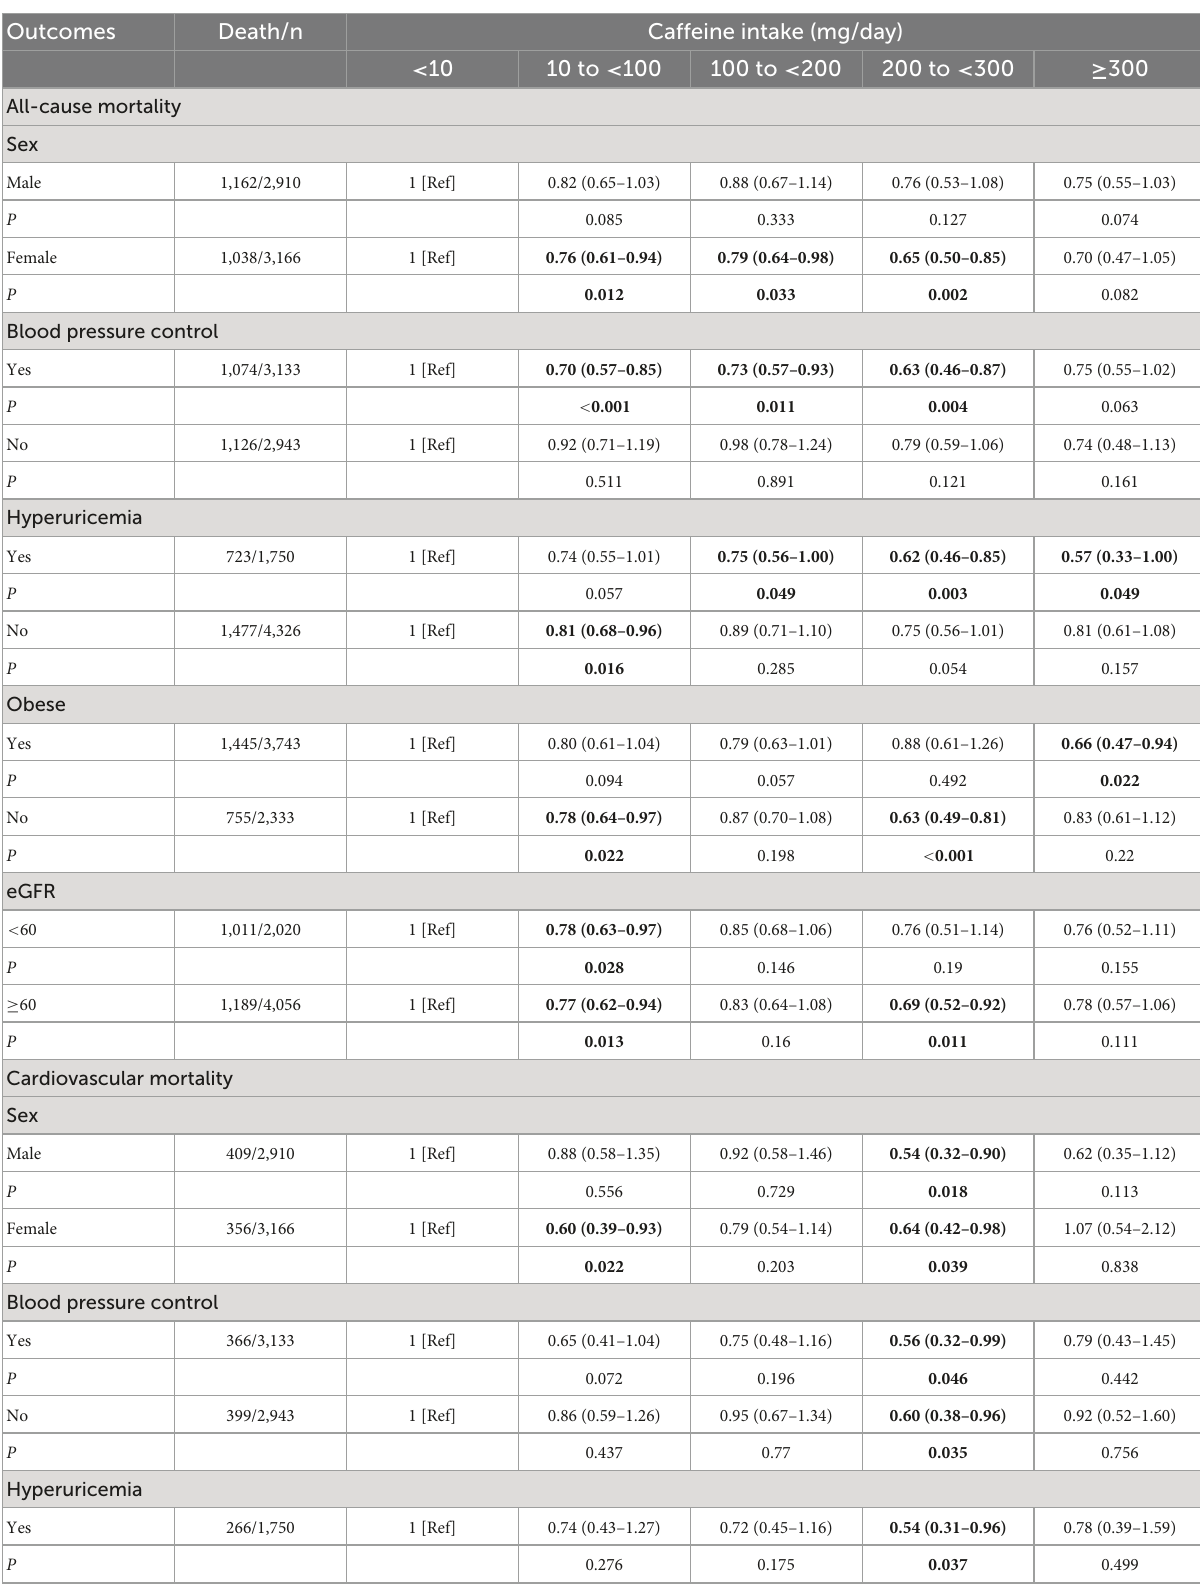
TABLE 3 Multivariable model 3 hazard ratios for all-cause and cardiovascular mortality of subgroups (Sex, Blood pressure control, Hyperuricemia, Obese, and eGFR), stratified by caffeine intake.